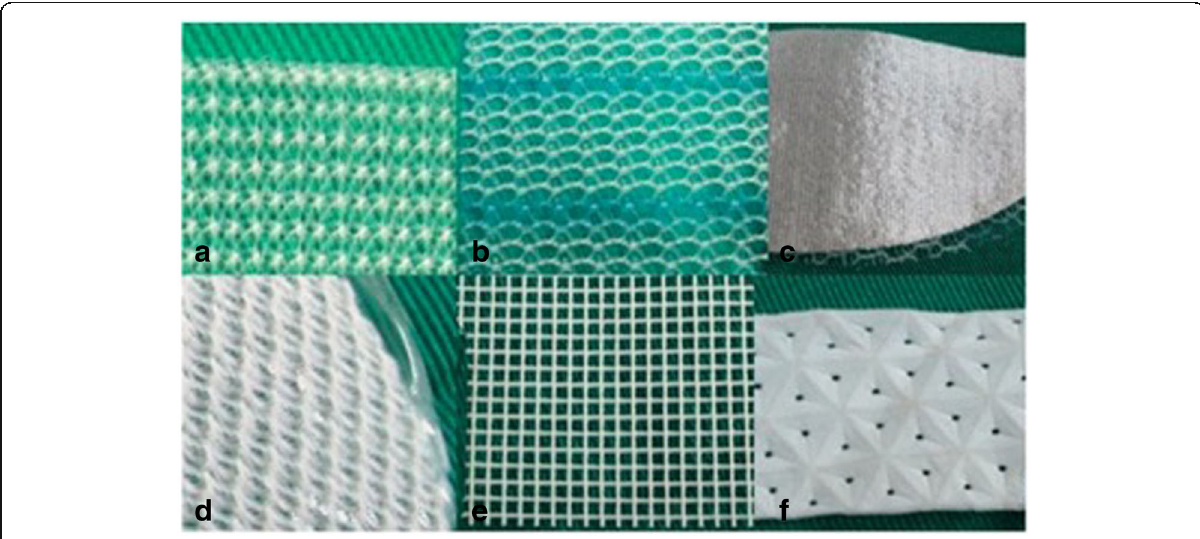
Fig. 2 Different types of mesh. a Polypropylene. b Polypropylene polyglecaprone. c Polypropylene — polydioxanon. d Polyester/collagen. e Polyester. f Polytetrafluoroethylene (PTFE) (with permission from reference